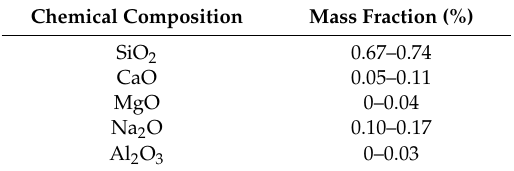
Table 1. Chemical composition of the common soda-lime glazing (mass fraction